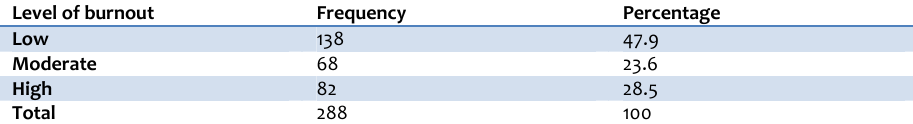
Table 5: Frequency and Percentage of Personal Accomplishment among Sample Teachers Level of burnout Frequency Percentage Low 138 47.9 Moderate 23.6 High 28.5 Total 100